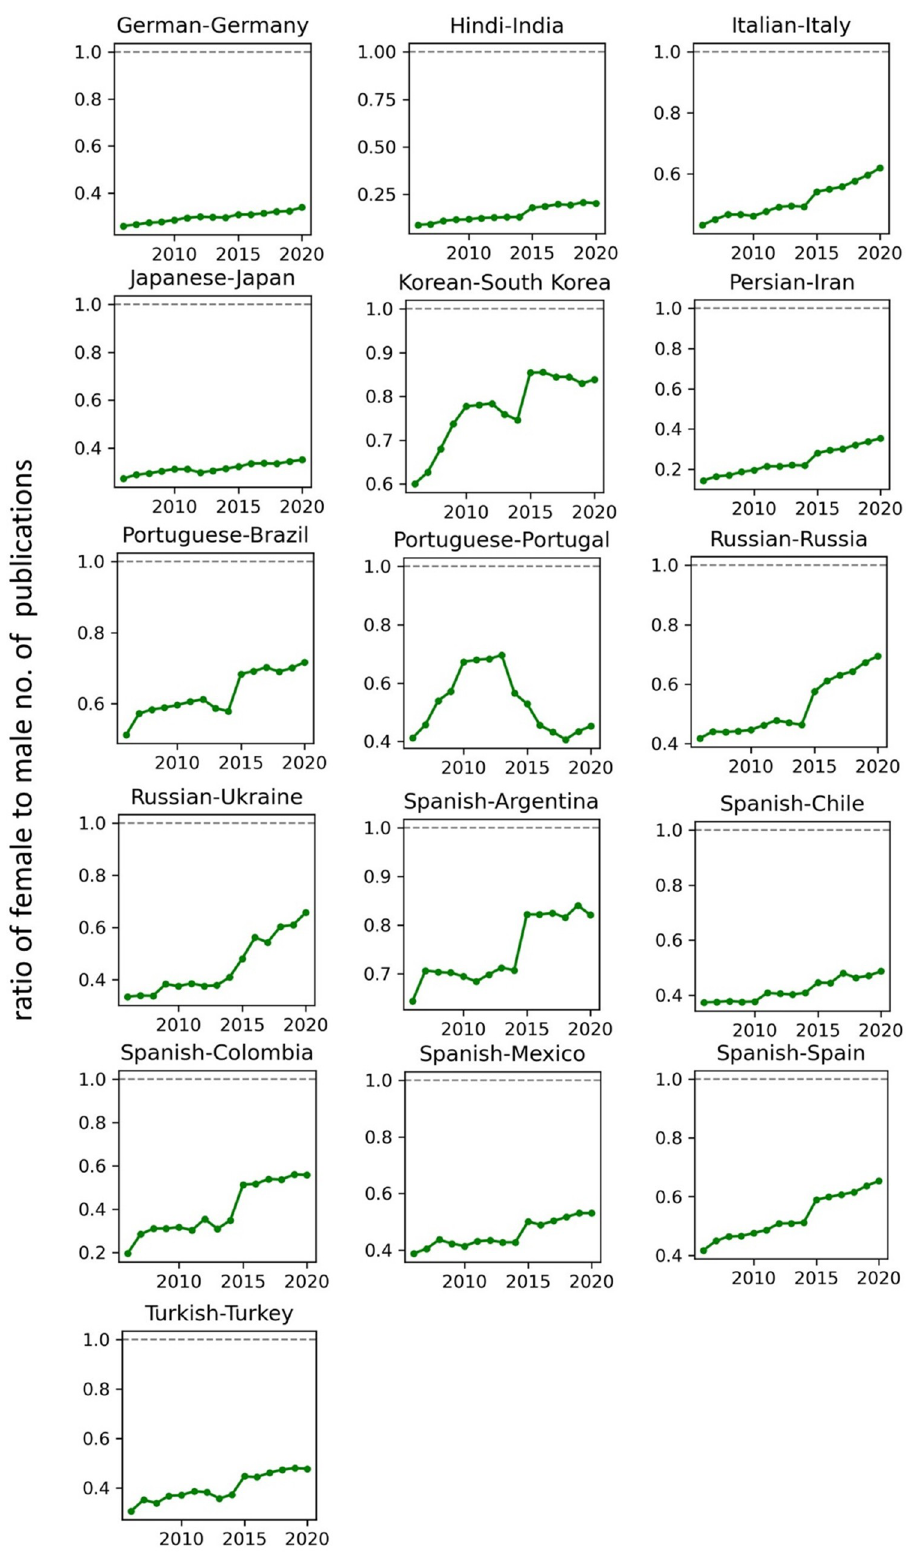
Fig 20. Ratio of female to male total research productivity, based on A-Z method (part 2).